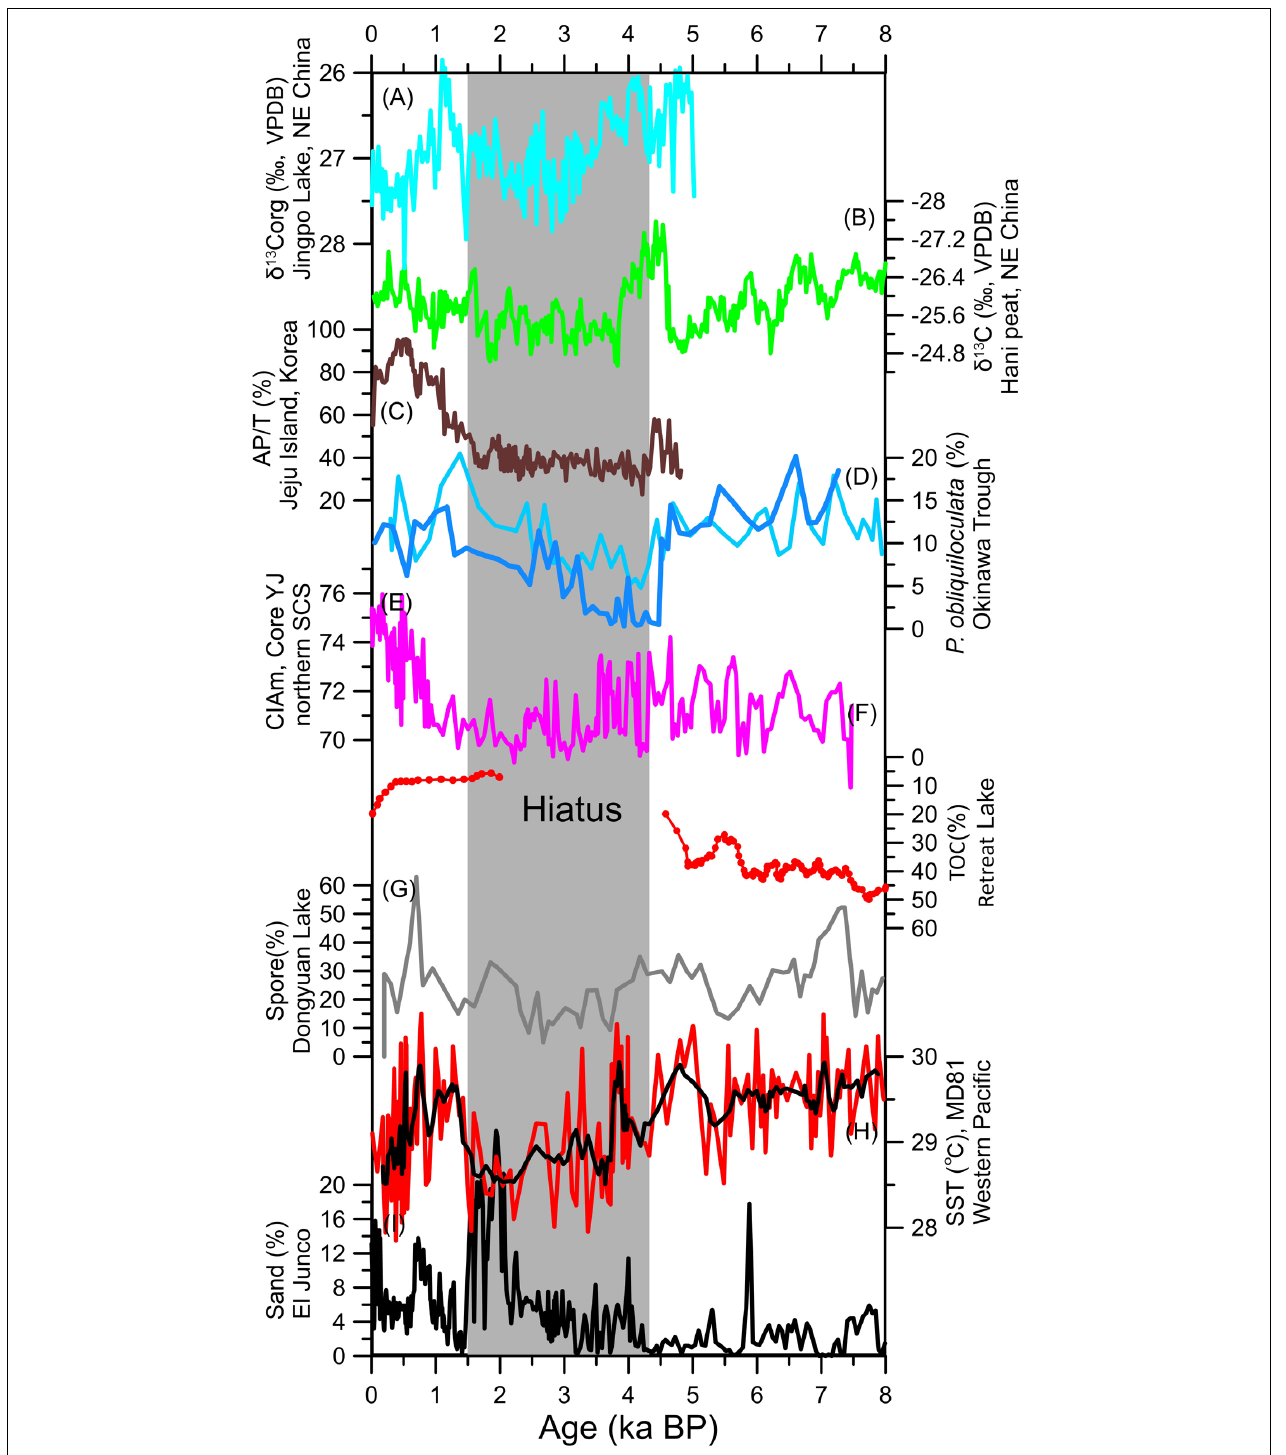
FIGURE 5 | Records showing the prolonged dry interval from 4 to 2 ka BP. (A) δ 13 Corg values from Jingpo Lake, northeastern China (Chen R. et al., 2015). (B) Cellulose δ 13 C record from Hani peat (Hong et al., 2005). (C) Arboreal pollen/total pollen (AP/T) ratios from Jeju Island, South Korea (Park et al., 2016). (D) Abundances of the foraminifera Pulleniatina obliquiloculata from the Okinawa Trough (Jian et al., 2000). (E) Records of chemical weathering proxies (CIAm) from the northern inner shelf of the South China Sea (Huang C. et al., 2018). (F) TOC record from Retreat Lake (Selvaraj et al., 2007). (G) Record of spore percentages from Dongyuan Lake (Lee and Liew, 2010). (H) SST records from the MD81 site in the western tropical Pacific (Stott et al., 2004). (I) Sand percentages from El Junco Lake, eastern tropical Pacific (Conroy et al., 2008).